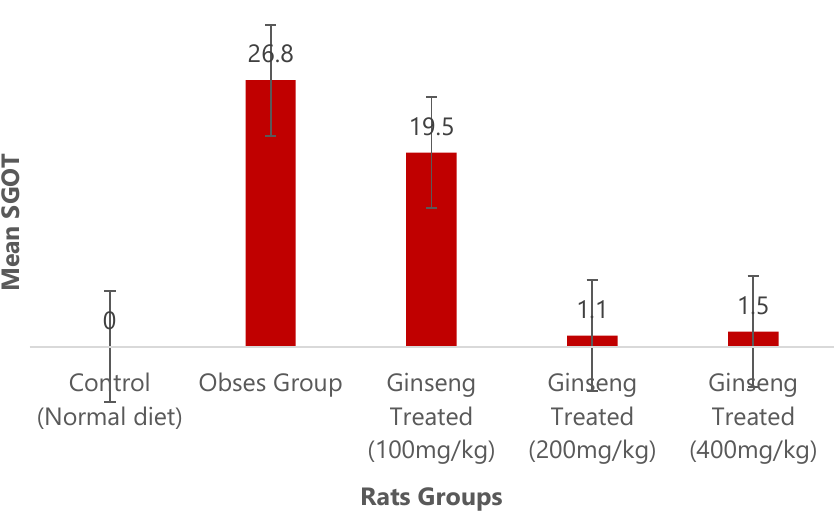
Figure 12: Comparison of mean SGPT in different groups.